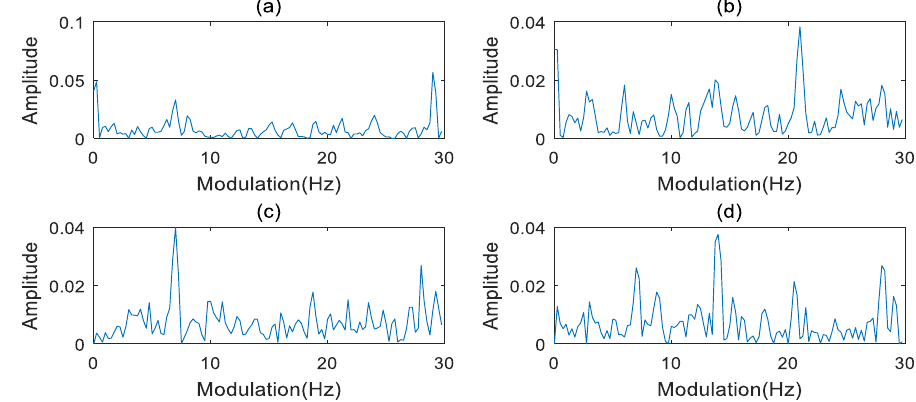
Sensors 2020 , 20 , x FOR PEER REVIEW 7 of 16 Figure 3. Simulation signals in frequency domain: ( a ) Group a; ( b ) Group b; ( c ) Group c; ( d ) Group d. Figure 3. Simulation signals in frequency domain : ( a ) Group a; ( b ) Group b; ( c ) Group c; ( d ) Group d.